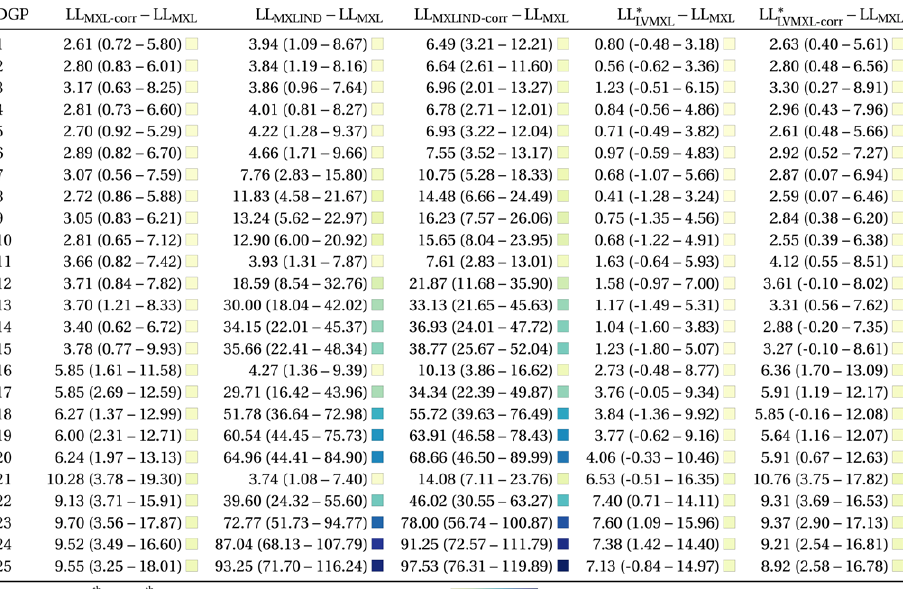
Table 2. Mean improvement in log-likelihood (choice) over respective DGP baseline MXL model across the 100 Monte-Carlo